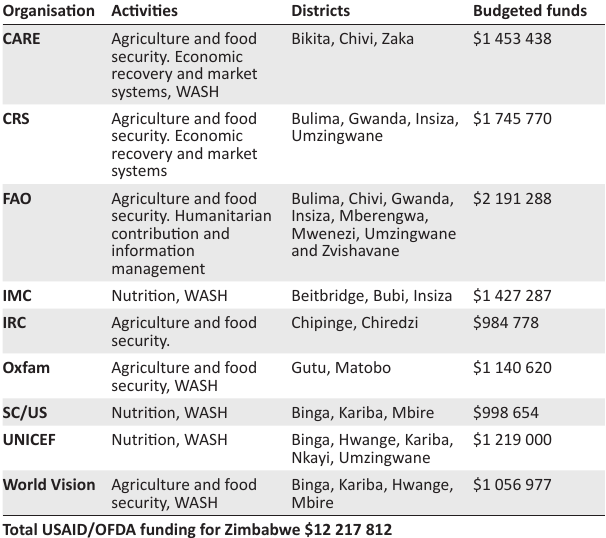
TABLE 2 : USAID humanitarian funding for the Southern Africa response in financial year